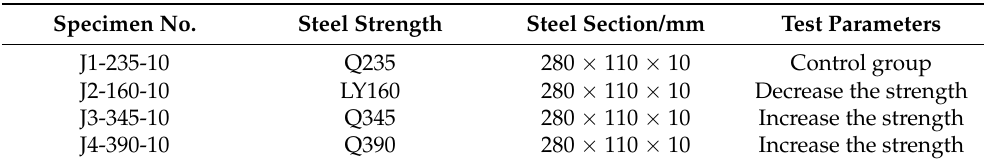
Table 1. Parameters of specimens.